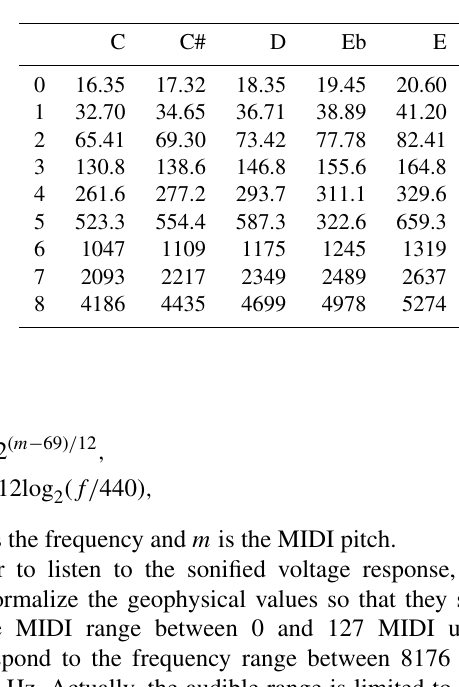
Table 1. Relationship between frequencies and